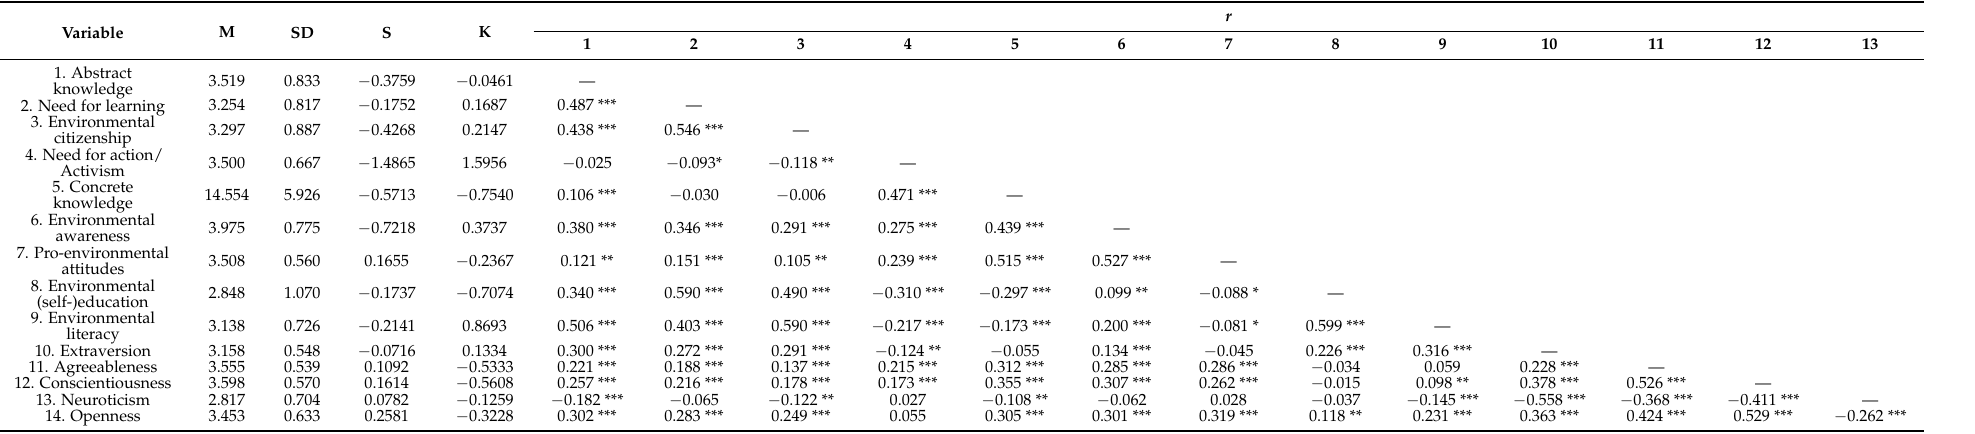
Table 1. Descriptive statistics of all variables